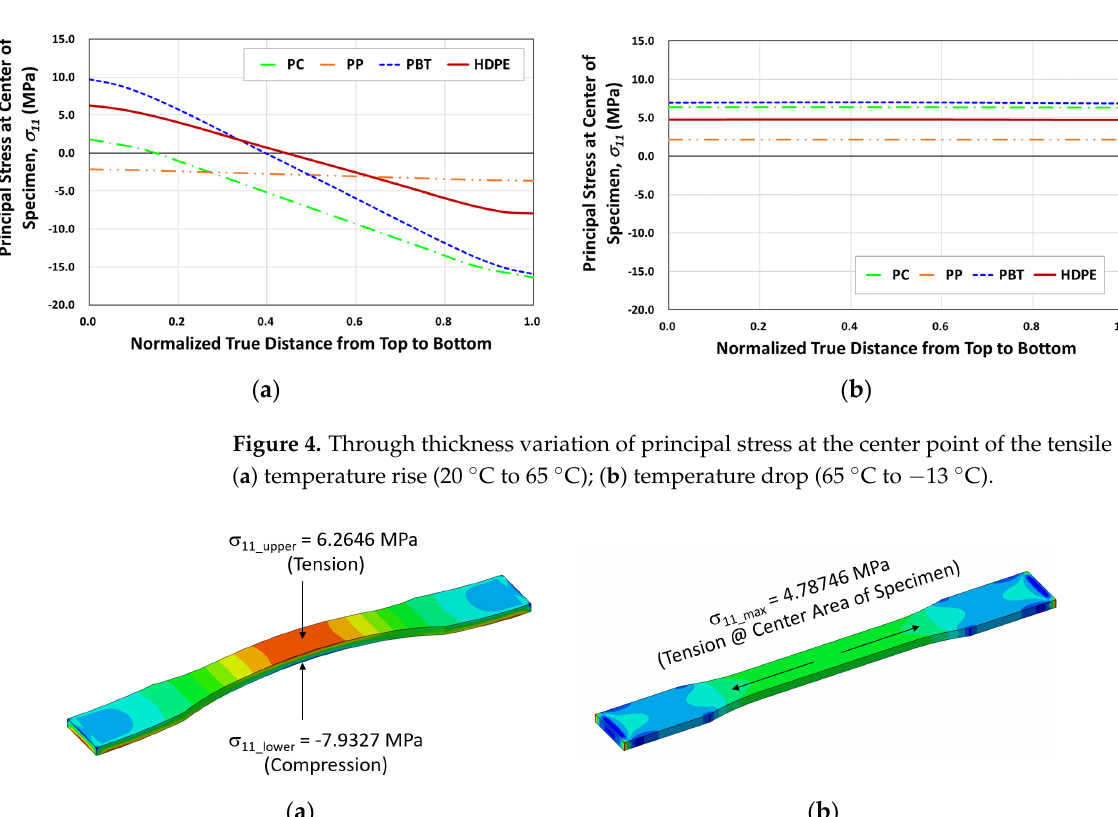
Figure 3. Four-year average quarterly seasonal temperature cycle estimated from the monthly average cycle (temperature varied daily, and the graph is a scheme where daily temperatures are made into a monthly average).